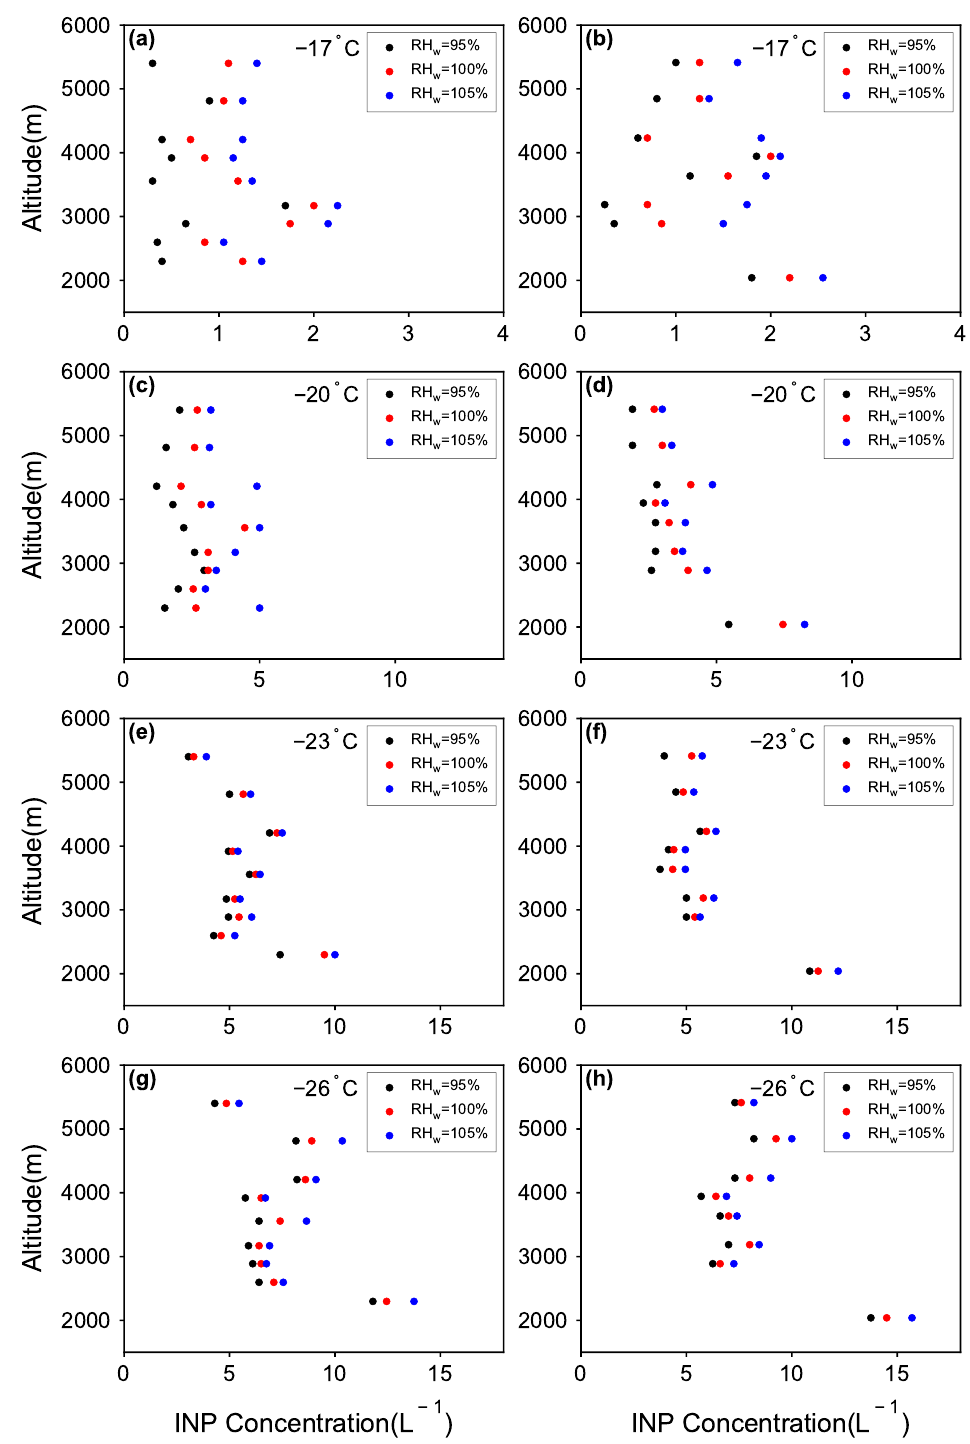
Figure 5. Vertical distribution of INP concentrations during the ascent stage ( a , c , e , g ) and the descent stage ( b , d , f , h